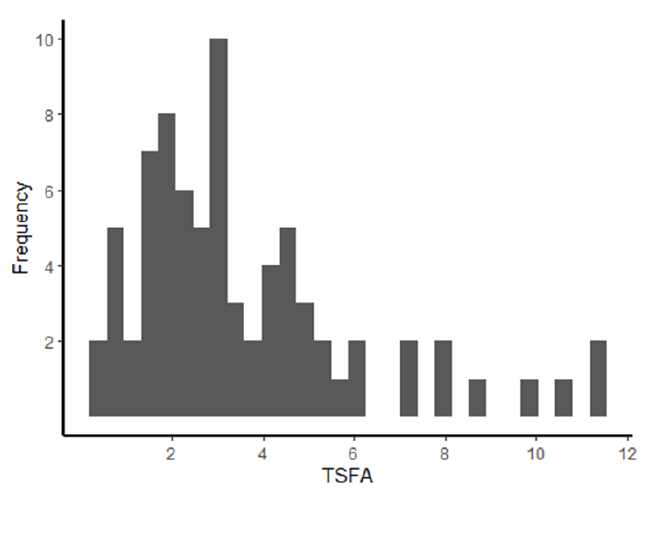
Table3: Major findings (N = 76 unless